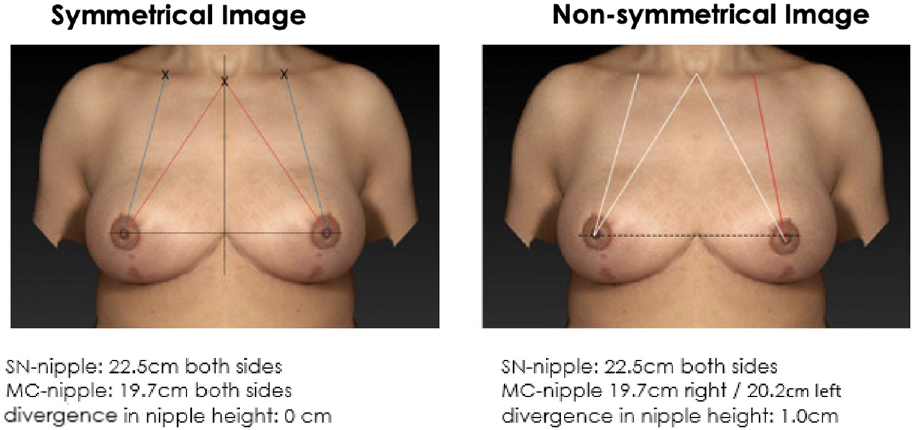
Figure 4. Symmetrical mirrored computer-simulated breast model and a non-symmetrical model (with a modified MC-to-nipple distance). In total, 92% of the plastic surgeons and 89% of the patients find a symmetrical breast with mirrored position of the NAC more attractive than a non- symmetrical breast. Figure 5. Non-symmetrical mirrored computer-simulated breast models with a modified MC-to- nipple distance and an SSN-to-nipple distance of +0.5 cm. In total, 56% of the plastic surgeons and 60% of the patients find the image with unaltered MC-to-nipple distance more attractive than the image with the unaltered SSN-to-nipple distance.